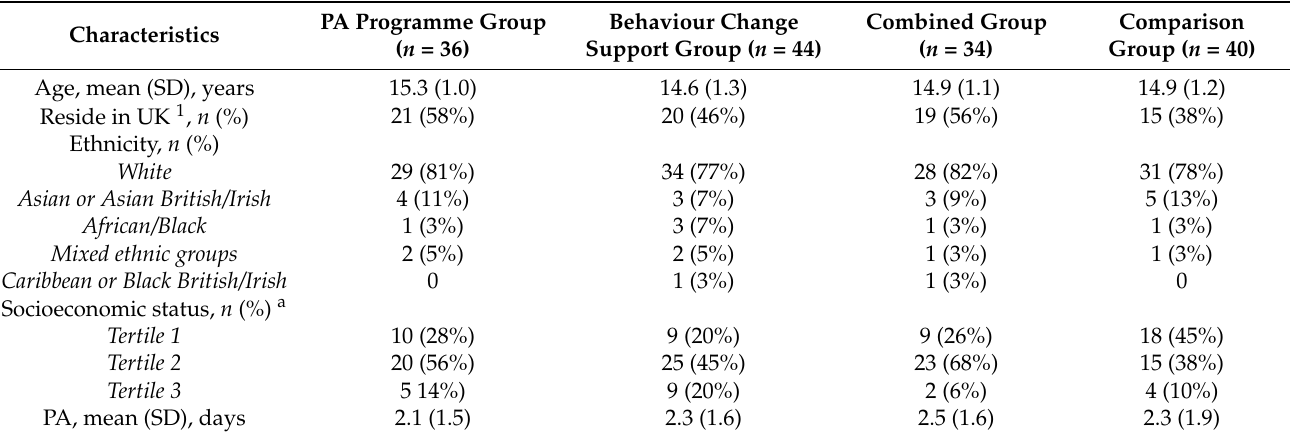
Table 4. Descriptive data for